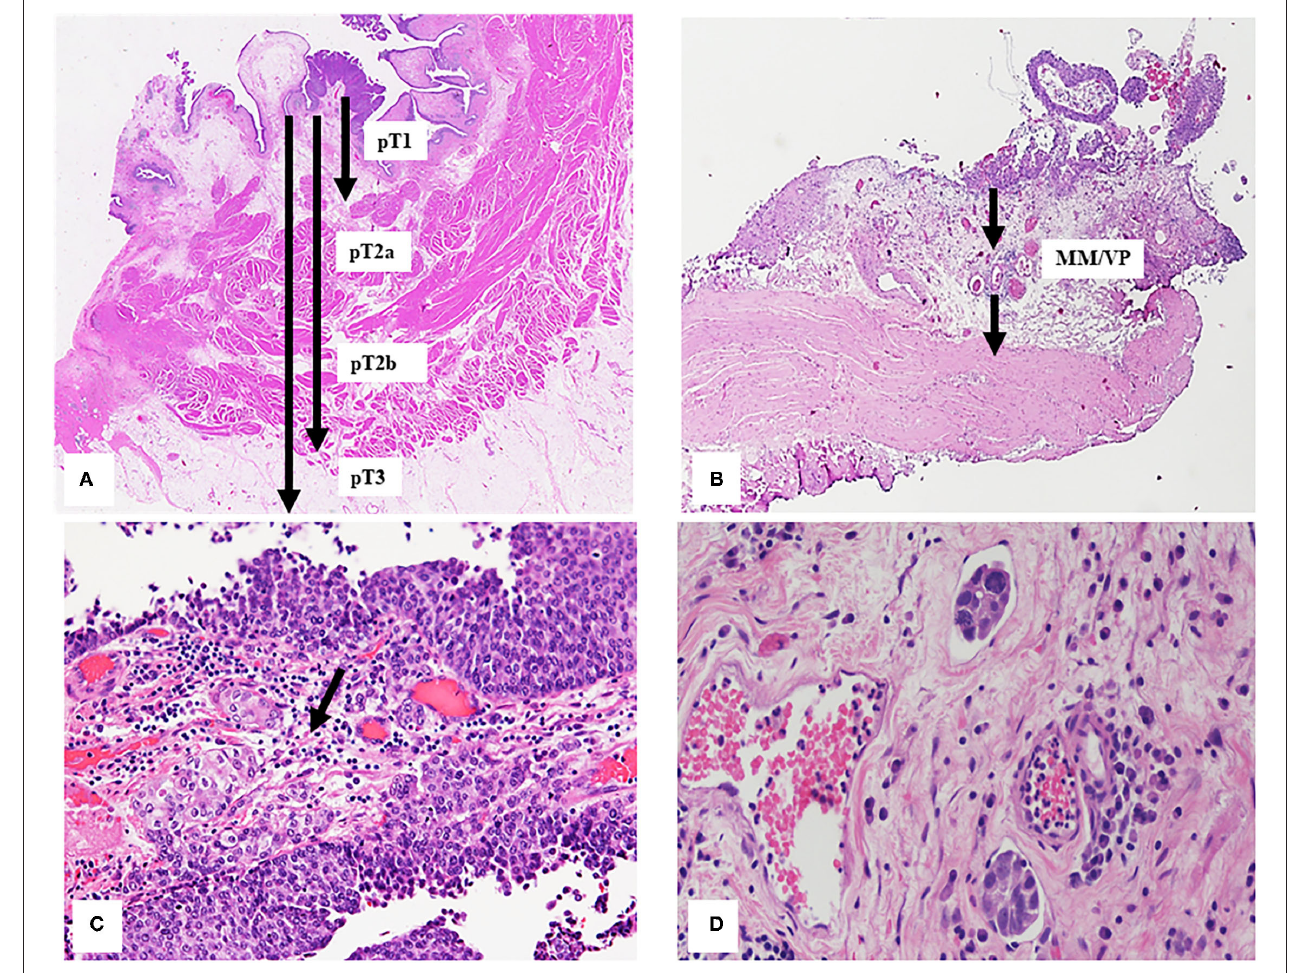
FIGURE 3 | (A) Extension of bladder tumor transmurally invasion classified considering 2017 version of AJCC TNM classification as described in the text. The arrows indicate different depths in relation to the different histological tumor stages. (B) Bladder wall Black arrows indicate the vascular plexus (VP) and the muscularis mucosae (MM), these divide the lamina propria in two part and represent the landmark to subclassified T1 tumors. (C) The arrow indicates the urothelial carcinoma infiltrating the lamina propria. (D) Small groups of tumor cells into two lymphatic